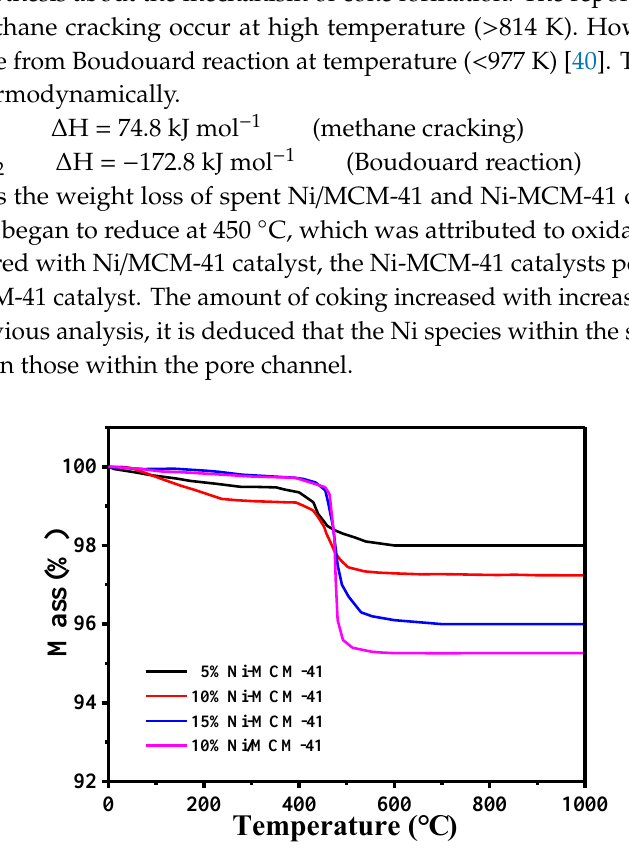
Figure 11. TGA of spent Ni/MCM-41 and Ni-MCM-41 catalysts.